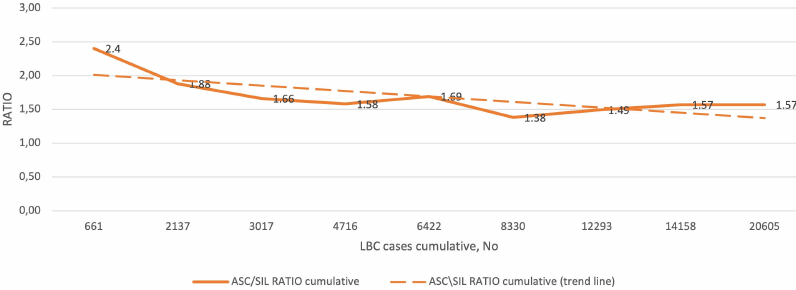
Figure 3. QC results for ASC/SIL in the study group (1–9 rounds). Abbreviations: QC, quality control; ASC, atypical squamous cells; SIL, squamous intraepithelial lesion; LBC, liquid-based cytology.